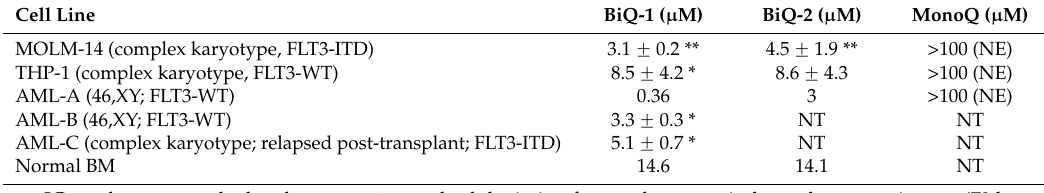
IC 50 values were calculated as mean ± standard deviation from at least two independent experiments (72 h exposure for cell lines and 48 h exposure for primary cells). If availability of primary blasts was limited, the IC 50 was obtained from a single experiment. BM = bone marrow; FLT3: Fms-like tyrosine kinase 3; IC 50 : concentration that decreases viable cell numbers by 50%; ITD = internal tandem duplication; NE = Not Effective; NT = Not Tested; WT = wild type. * p < 0.05; ** p < 0.0001 compared with the value for normal BM.